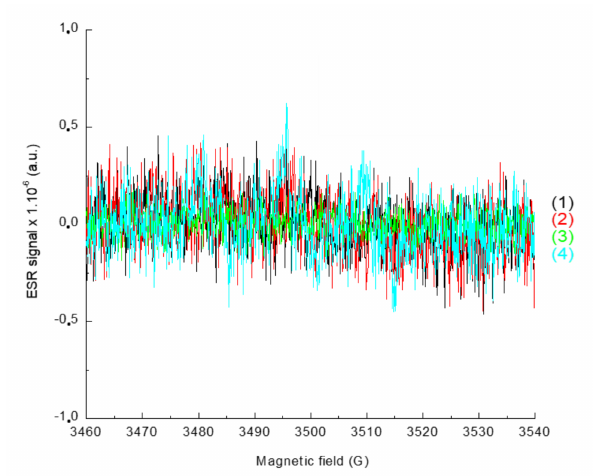
Figure 8. ESR-Spin trapping spectrum of Napht-B1: (1) before irradiation; (2) after 180 s of irradiation with LED@405 nm (I ≈ 110 mW · cm − 2 ) exposure; (3) and (4) in combination with Ar 2 I + PF 6 − (3) before irradiation and (4) after 180 s of irradiation with LED@405 nm (I ≈ 110 mW · cm − 2 ); under air; phenyl- N -tert-butylnitrone (PBN) is used as a spin trap, in acetonitrile.